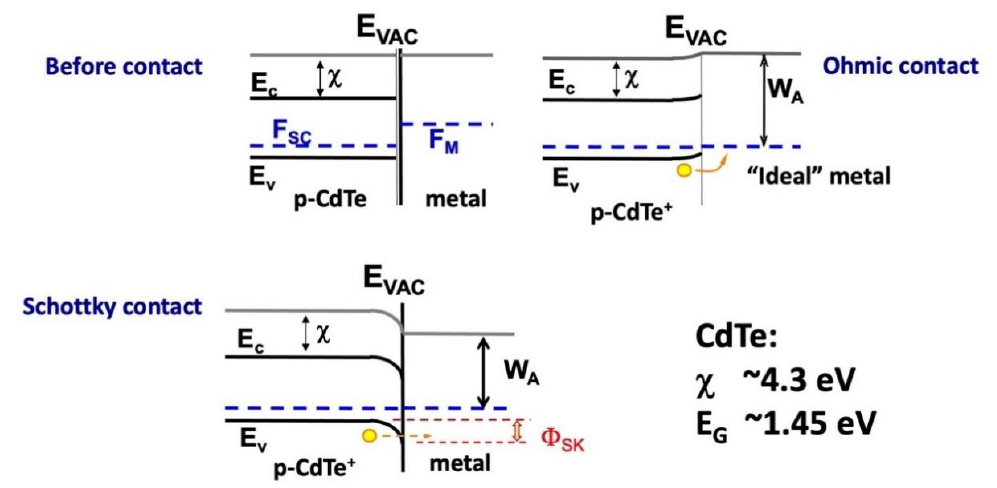
Figure 7. Band alignment for a quasi ohmic contact and Schottky contact.